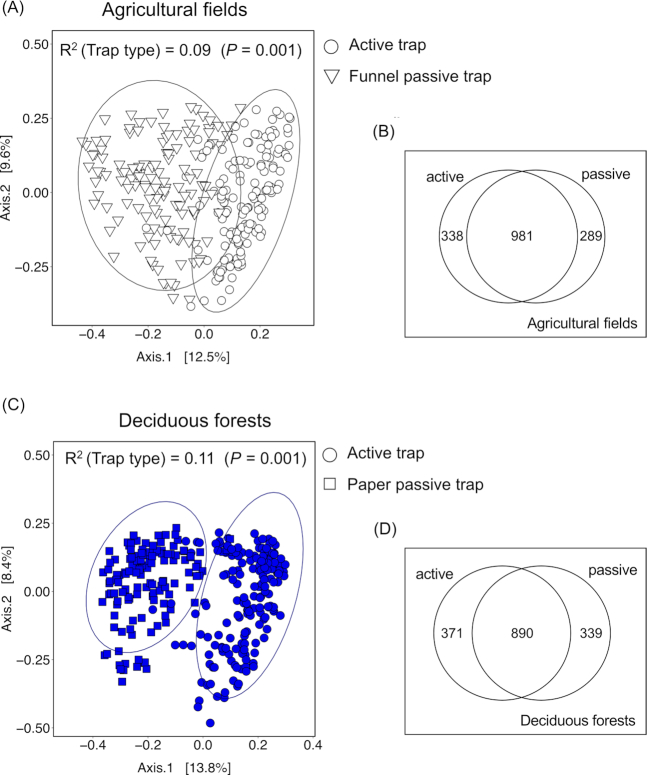
Ordination plots of a principal coordinate analysis and Venn diagrams of the spore communities collected in (A, B) agricultural fields and (C, D) deciduous forests by active and passive spore traps. The 95% confidence ellipse for each group is shown. The R2 values are based on a PERMANOVA analysis performed with the adonis2 function in R. Numbers in Venn diagrams display the number of species for each type of spore trap.